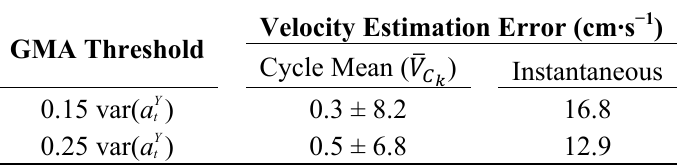
Table 4. The effect of changing the segmentation threshold of geometric moving average (GMA) by a factor of 5% on velocity estimation. Estimation error in the cycle mean velocity (MEAN ± SD) and instantaneous velocity (RMS) are